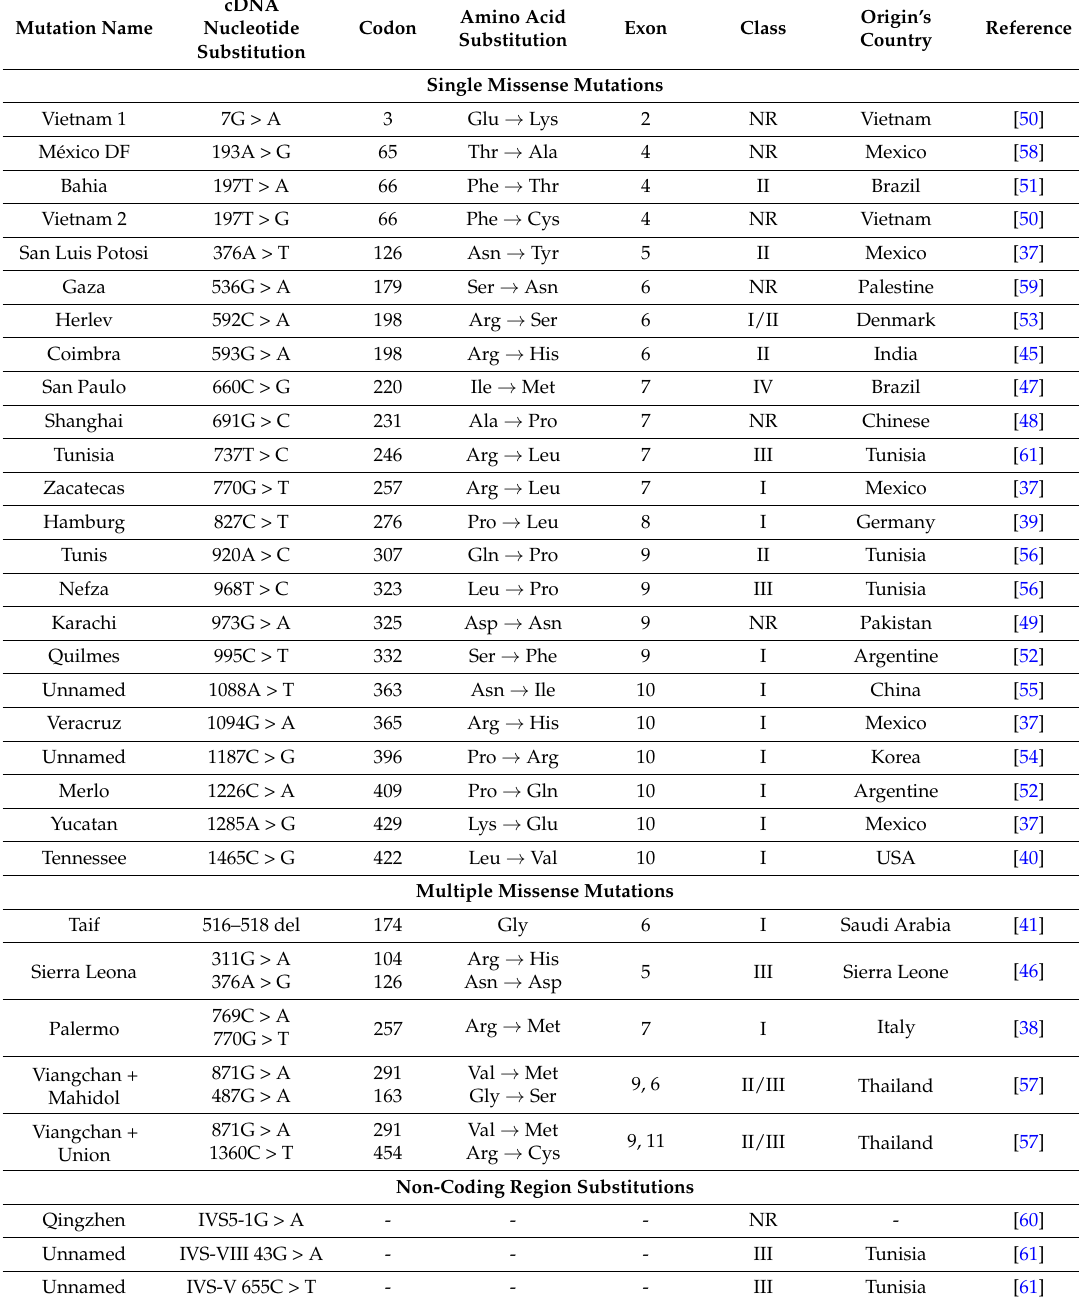
Table 1. A list of G6PD mutations not included in the Minucci review plus those most recently